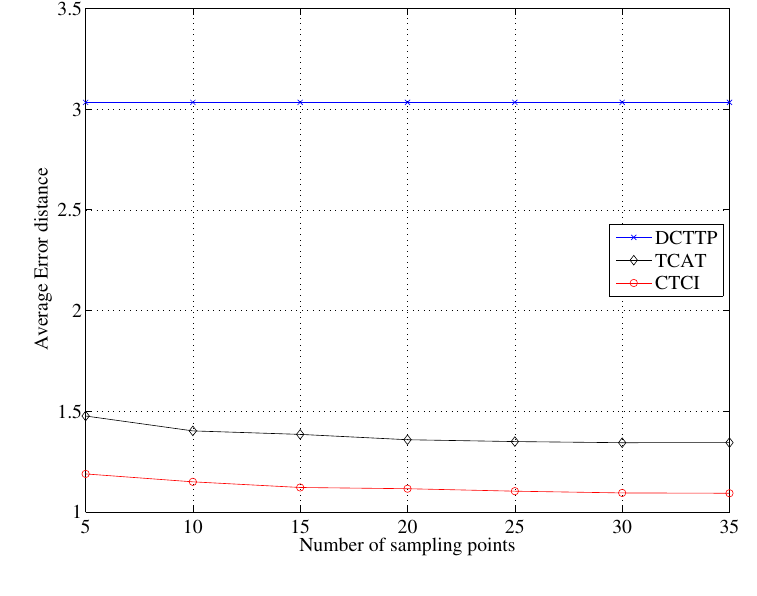
Figure 20. Impact of the sampling points on the average error